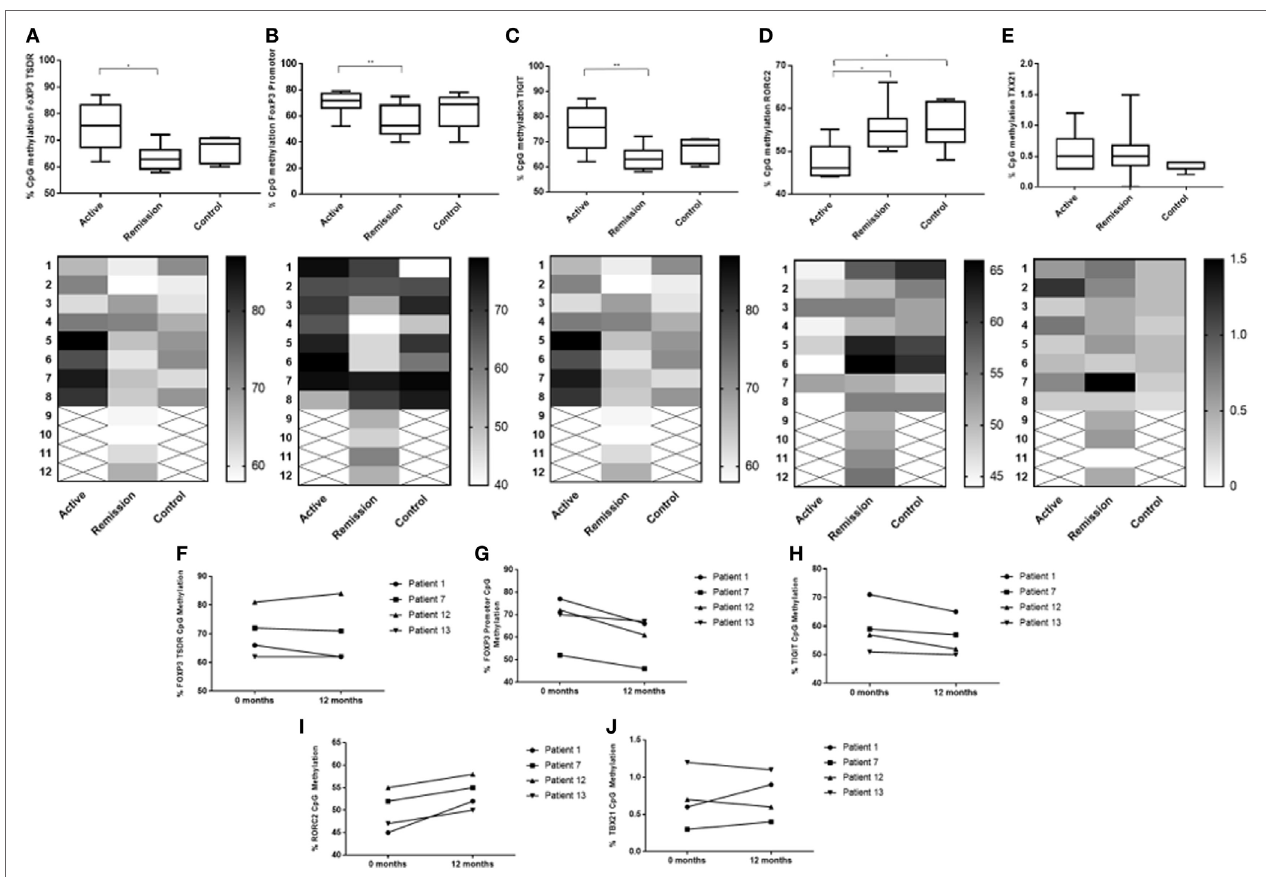
FigUre 8 | Comparison of % DNA CpG site methylation levels between the three subject groups (a–e) and change in % methylation within individual patients diagnosed with active disease at 0 month (commenced on oral treatment) and at 12 months, when disease had resolved (F–J) . (a) Between subject % methylation at FOXP3 Treg-specific demethylated region (TSDR) (49117116). (B) Between subject % methylation at FOXP3 promoter (49121204). (c) Between subject % methylation at TIGIT (114012658). (D) Between subject % methylation at RORC2/ROR γ T (151798858). (e) Between subject % methylation at TBX21/T-BET (45810951). (F) Change in individual % methylation at FOXP3 TSDR (49117116). (g) Change in individual % methylation at FOXP3 promoter (49121204). (h) Change in individual % methylation at TIGIT (114012658). (i) Change in individual % methylation at RORC2/ROR γ T (151798858). (J) Change in individual % methylation at TBX21/T-BET